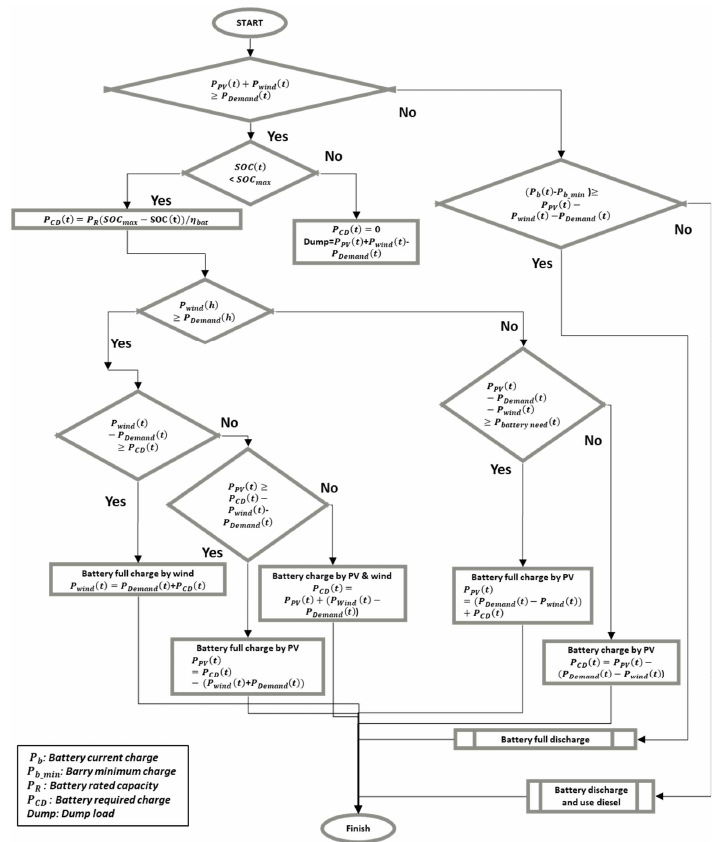
Figure 2. Power control strategy flowchart .